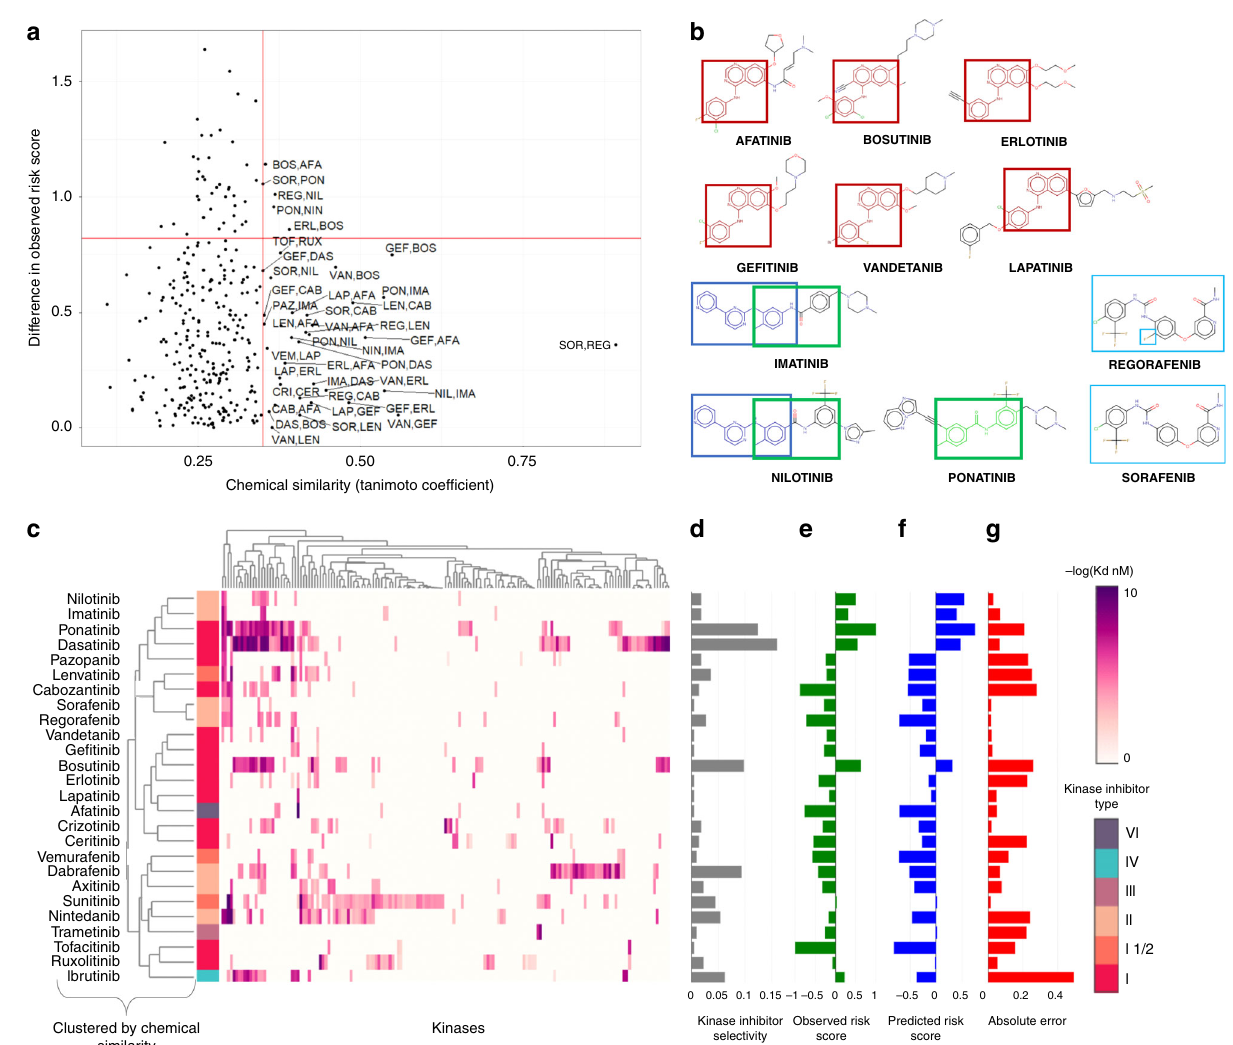
Fig. 5 Structure – activity – similarity (SAS) maps of kinase inhibitor activity and cardiotoxicity. a A SAS map relating pairwise chemical similarity measured by Tanimoto coef fi cient (Tc) derived from a weighted average of 4 chemical fi ngerprints (ECFP4, ECFP2, Daylight, and MACCS), between pairs of 26 kinase inhibitors (Table 1) and their difference in cardiotoxicity scores (DCS). The threshold for chemical similarity was the top 10% value in the distribution of Tc values: 0.38. The threshold value for DCS was half of the maximum DCS score: 0.82. b Highlighted chemical scaffolds for distinct kinase inhibitors observed in the upper- and lower-right regions. c Binding pro fi le of kinase inhibitors based on data from Klaeger et al. 5 . Kinase inhibitors were hierarchically clustered based on chemical similarity, and kinase inhibitors are annotated by their binding mode (e.g., type I, type I1/2, type II, type III, type IV, or type VI) 6 . d Kinase inhibitor selectivity scores at 500 nM K d . e Observed cardiotoxicity risk scores were normalized to zero and ordered based on hierarchical clustering of the kinase inhibitors. f Predicted cardiotoxicity risk scores were normalized to zero and ordered based on hierarchical clustering of the kinase inhibitors. g Absolute error from observed and predicted cardiotoxicity risk scores. Source data are provided in source data fi